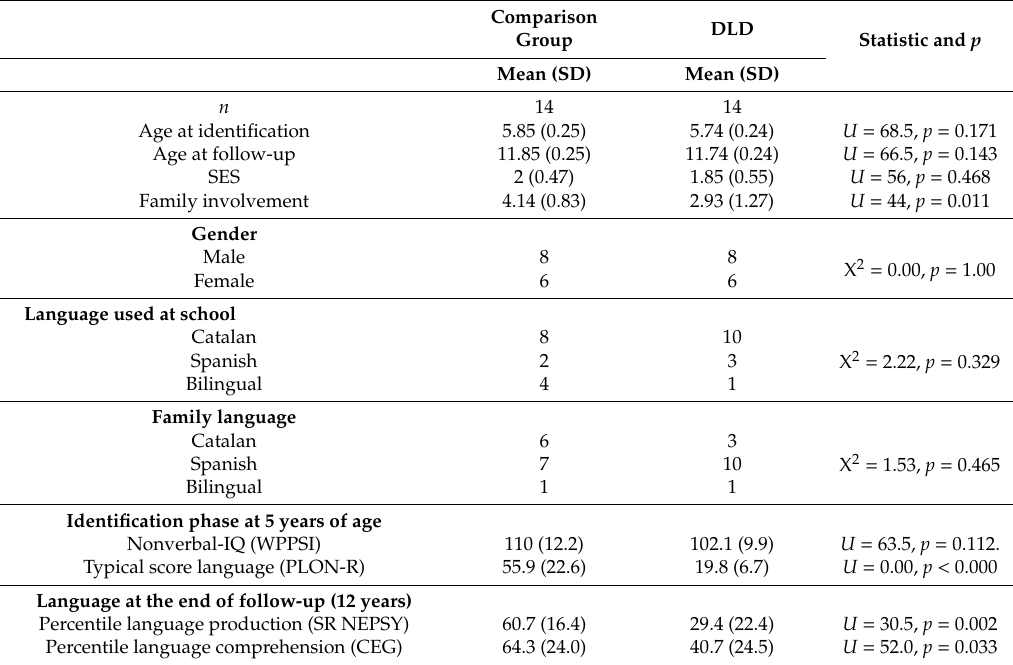
Table 1. Demographic and linguistic data of